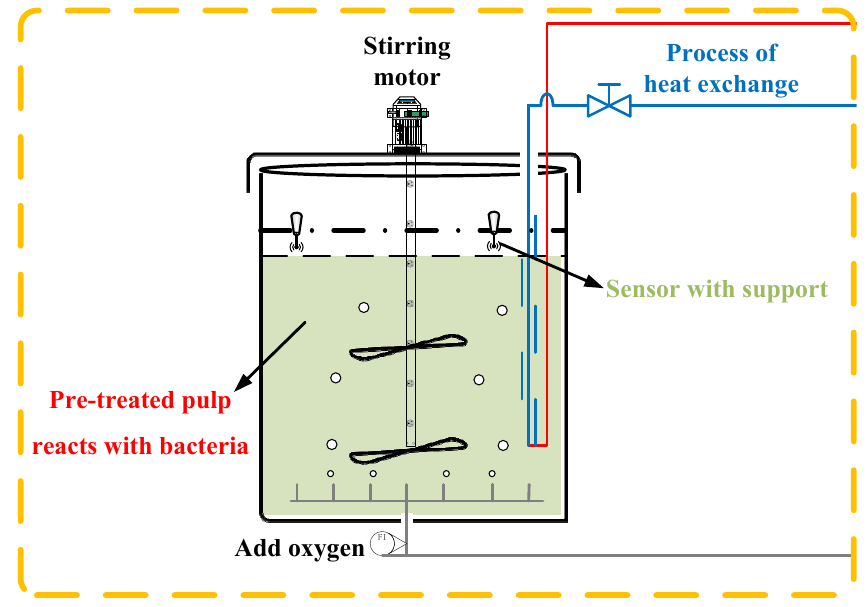
Figure 3. The basic structure of the oxidation tank.